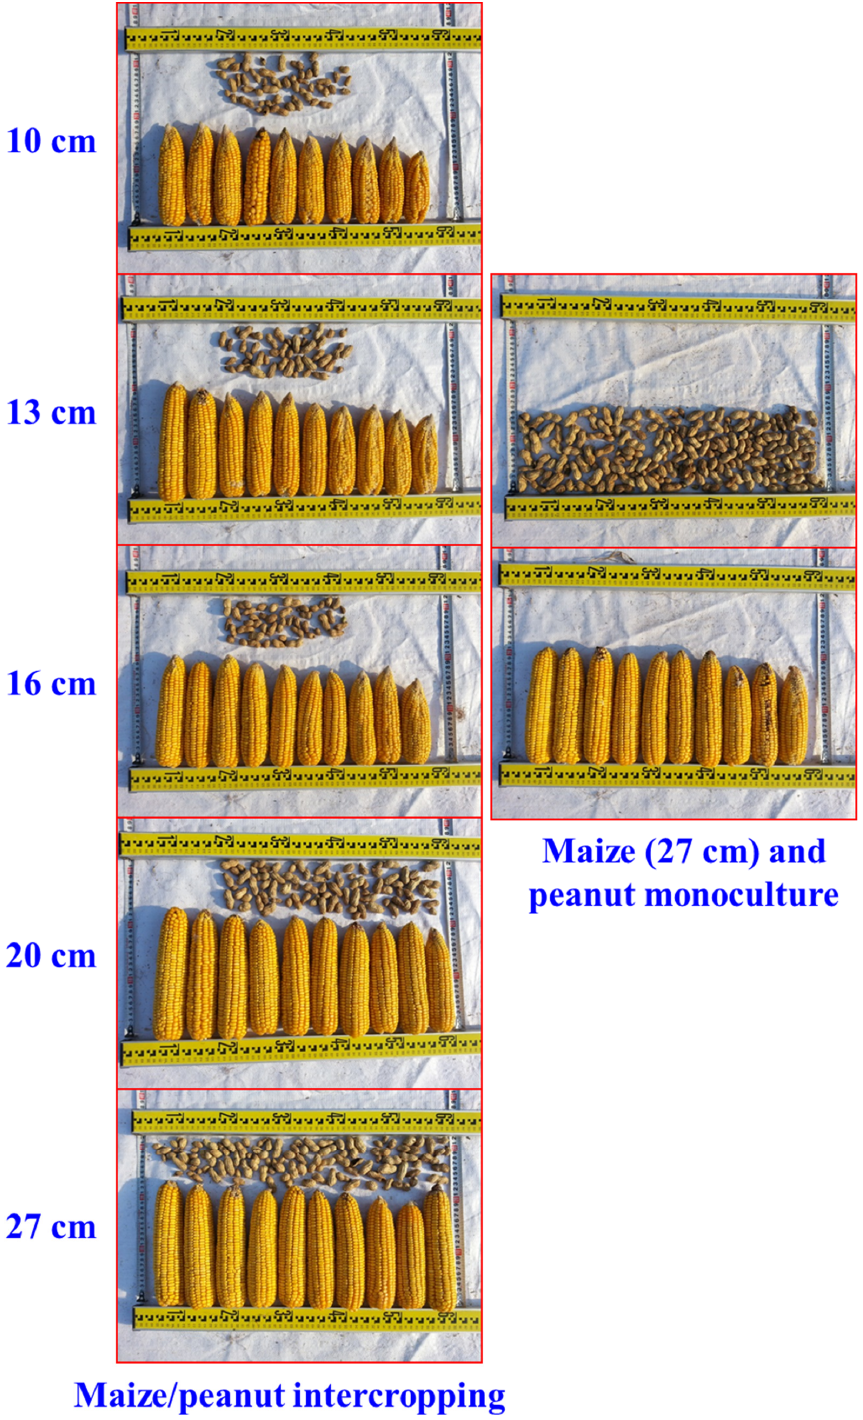
Figure 2. Maize ears (10 plants) in intercropping at various maize inter-plant distances and in monoculture, and corresponding peanut pods (two adjacent rows of peanut in 1.0 m length) in Licheng.